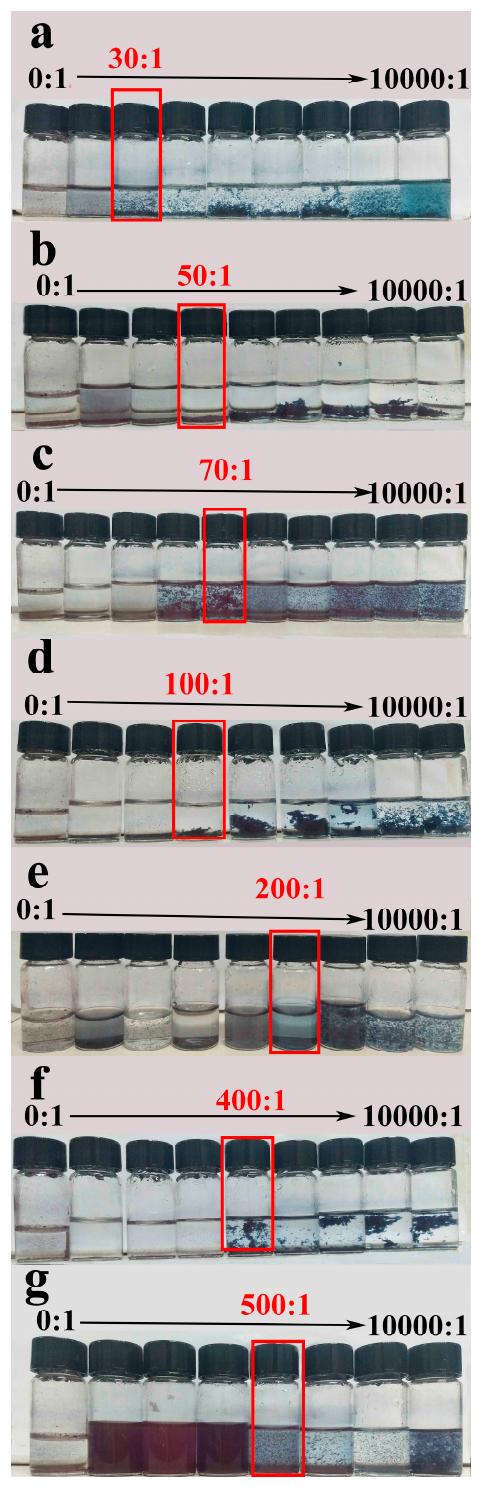
Figure 4. Digital image of PBI-1 aggregates assembled in various organic acids corresponding to di ff erent r values, from 0:1 to 10,000:1. ( a ) p-Toluenesulfonic acid, ( b ) oxalic acid, ( c ) malonic acid, ( d ) citric acid, ( e ) formic acid, ( f ) glutaric acid and ( g ) acetic